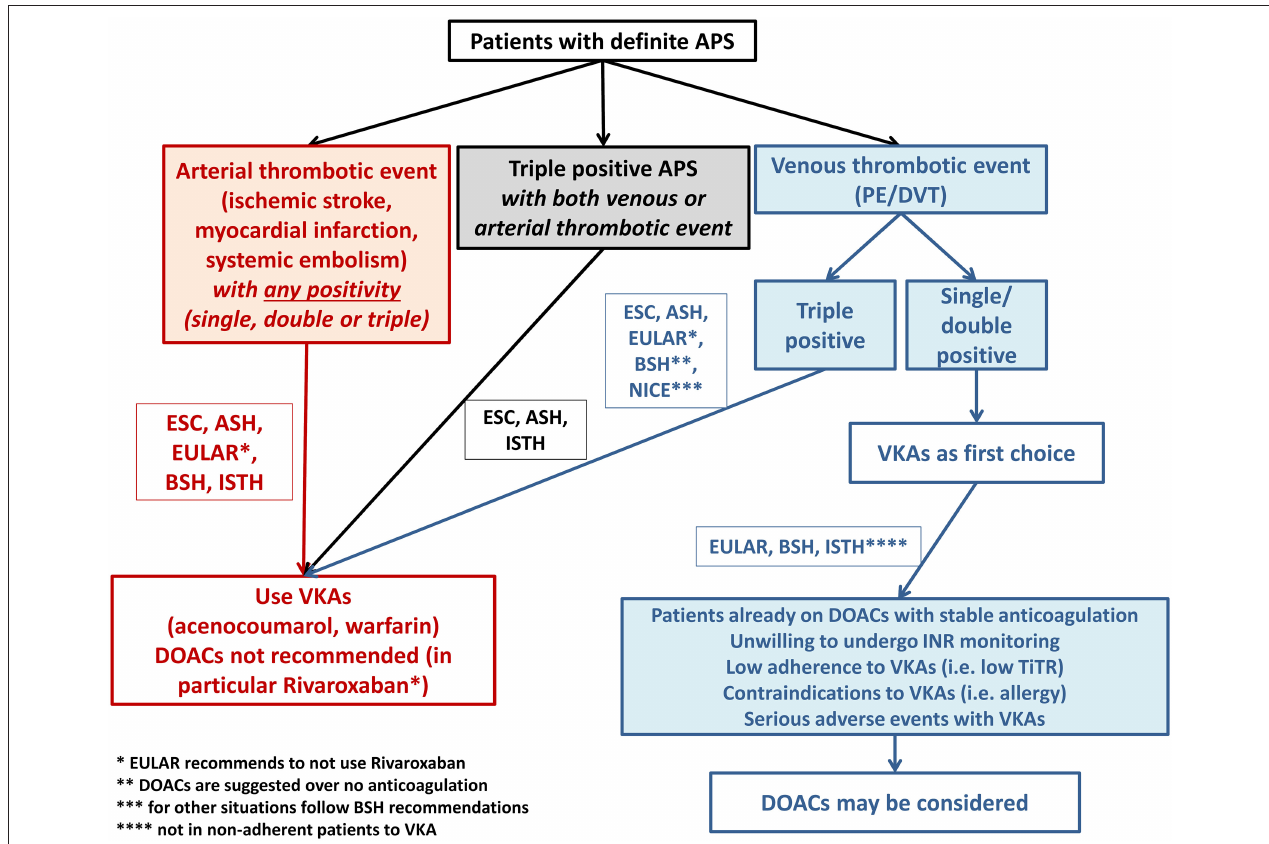
FIGURE 3 | Summary of guidelines recommendations on anticoagulant treatment prescription in patients with antiphospholipid